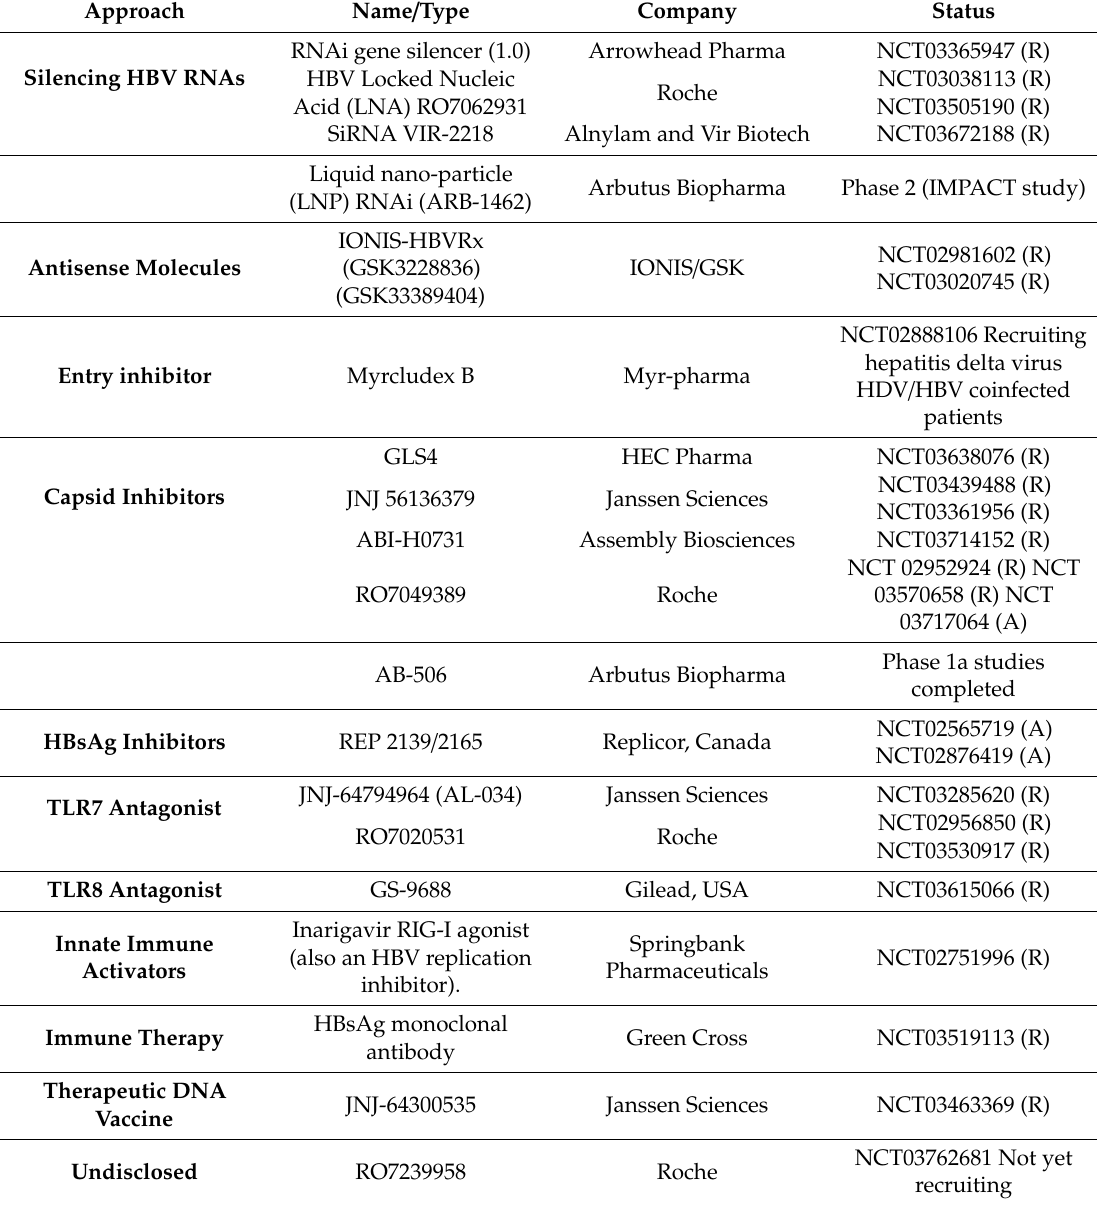
Table 1. Current clinical trials of new hepatitis B virus (HBV) therapies (Phases I / II and